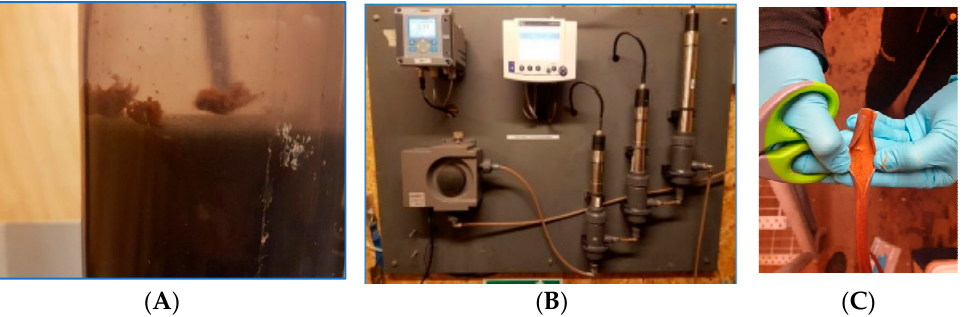
Figure 3. Pilot studies conducted at Slangerup waterworks. ( A ) Visible growth at the top of pilot column with anaerobic groundwater with methane. ( B ) Hoses in control panel which clogged due to growth in study with anaerobic groundwater. ( C ) Hose with iron precipitation in study with vacuum stripping.